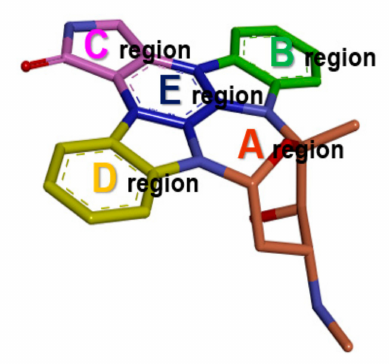
Figure 1. Structure of staurosporine. ATP binding site of DYRK1A and GSK3 β was divided into five regions (A–E) based on staurosporine’s binding mode. Various regions occupied by the ligand are highlighted in di ff erent colors (A: wheat, B: green, C: pink, D: yellow, E: